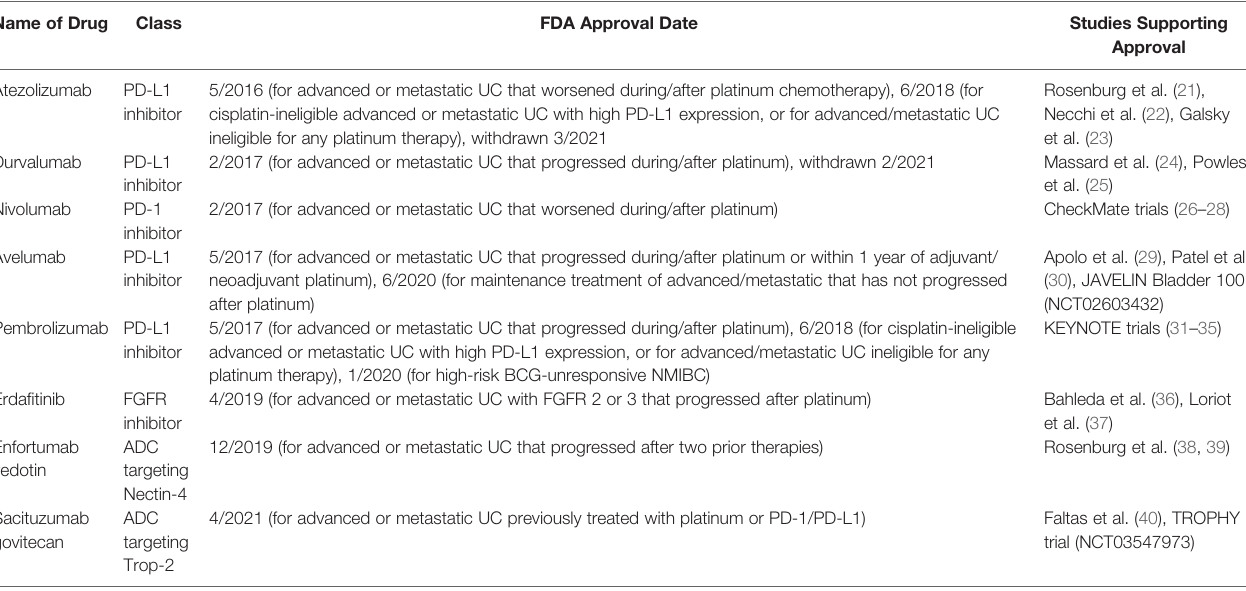
TABLE 1 | FDA approval timeline for novel UC therapies from 2015 to